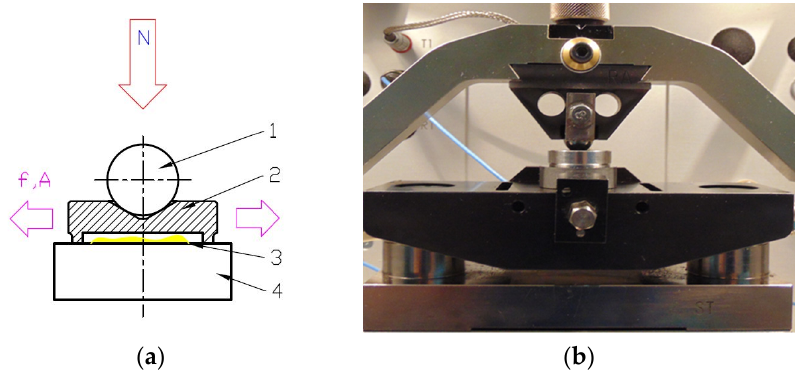
Figure 3. A scheme of contact configuration ( a ): N—normal load, f—frequency of oscillation, A—amplitude, 1—ball, 2—self aligning counter sample, 3—lubricant, 4—tested sample; picture of Optimol SRV5 test chamber with mounted samples ( b ).